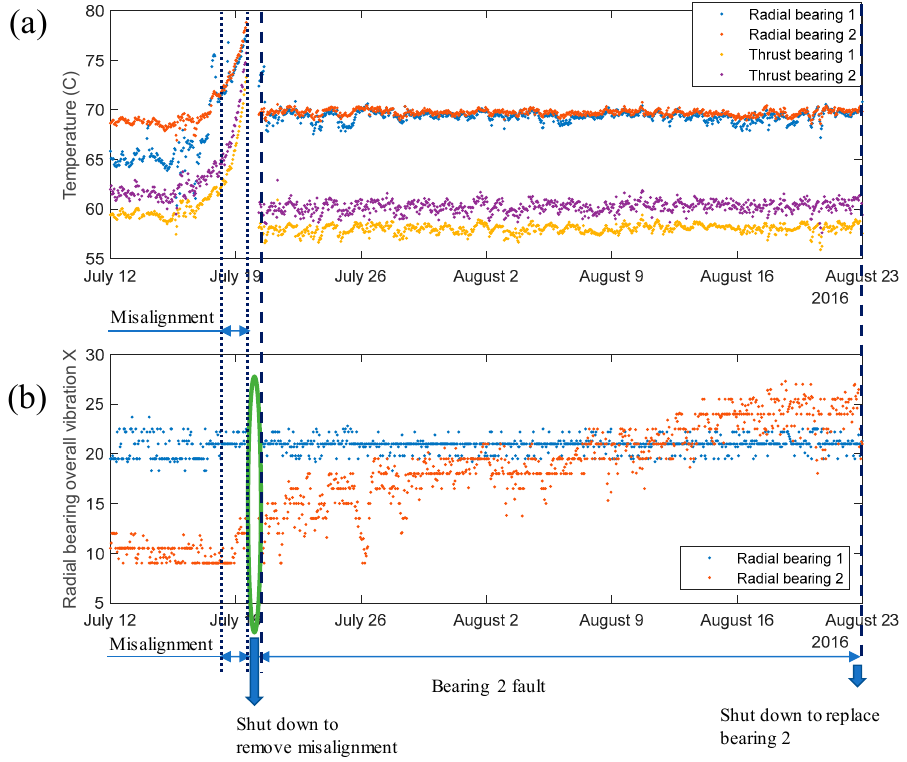
Figure 12. Measurements of the pump from 12 July to 23 August 2016. ( a ) The increase in the pump bearings’ temperature due to misalignment. ( b ) The increase in the pump bearings’ vibration amplitude due to a bearing fault.